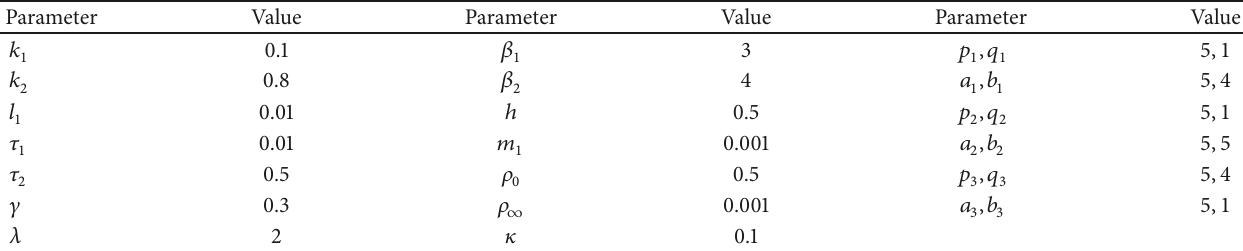
Table 1: Parameters of the control